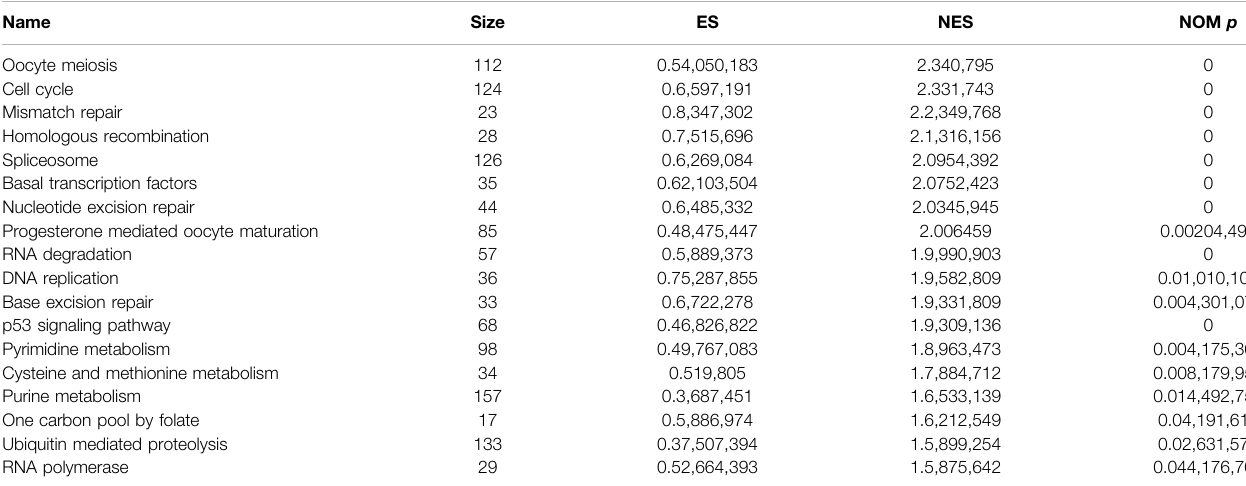
TABLE 4 | Mechanisms of upregulated SPDL1 involved in the occurrence and development of ESCA based on GSEA.